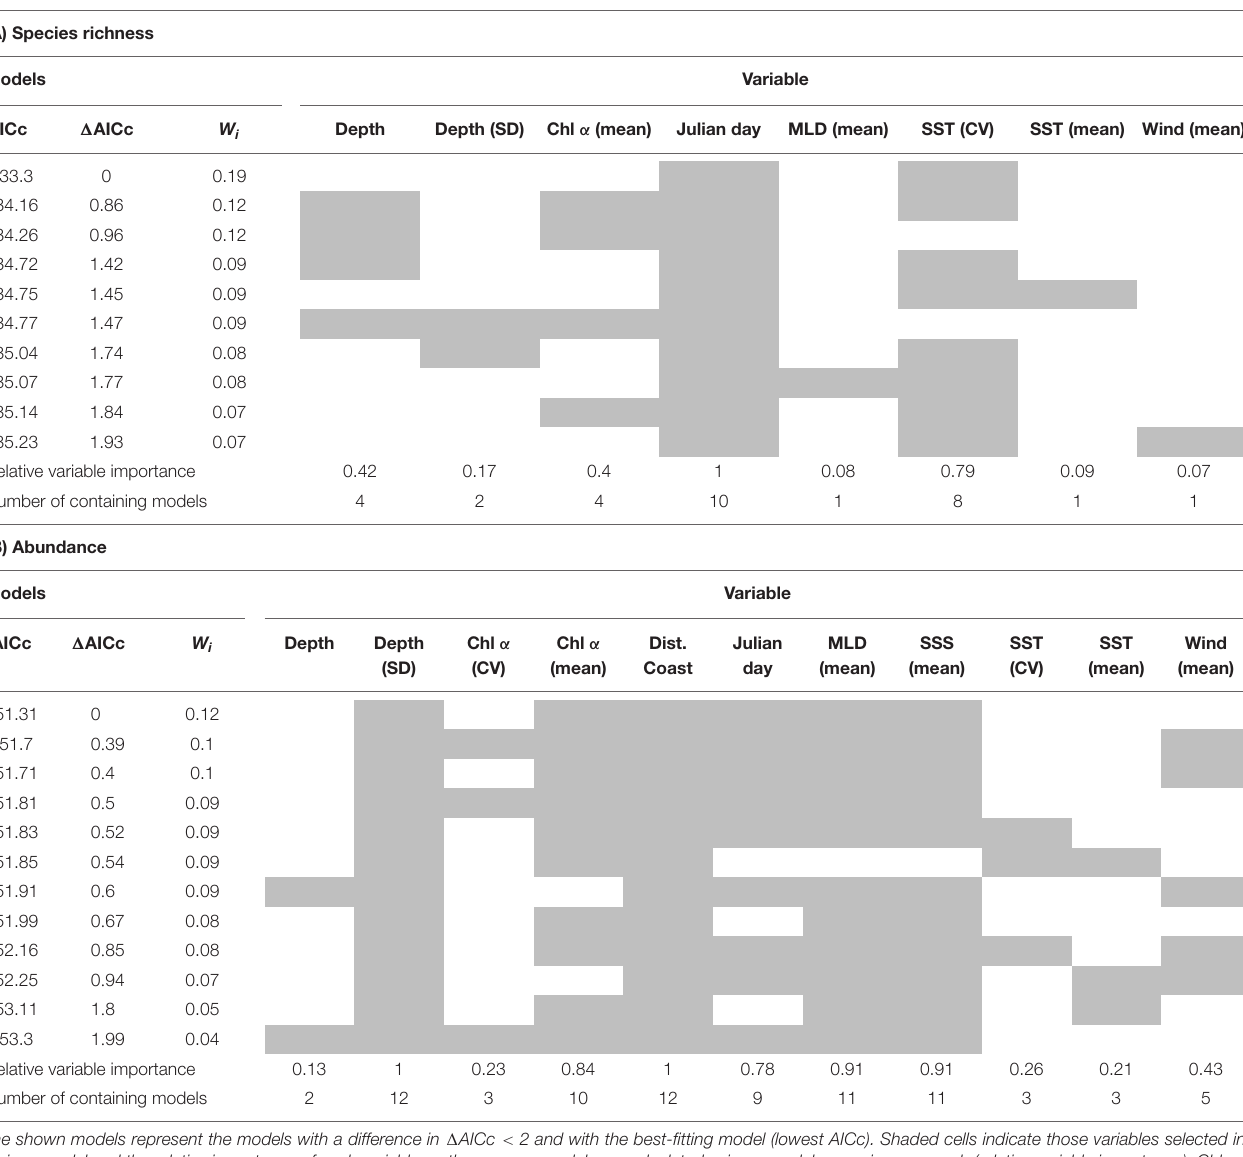
TABLE 3 | Best-fitting GLMs showing the most important environmental variables in the relationships environment-species richness (A) and environment-abundance (B)